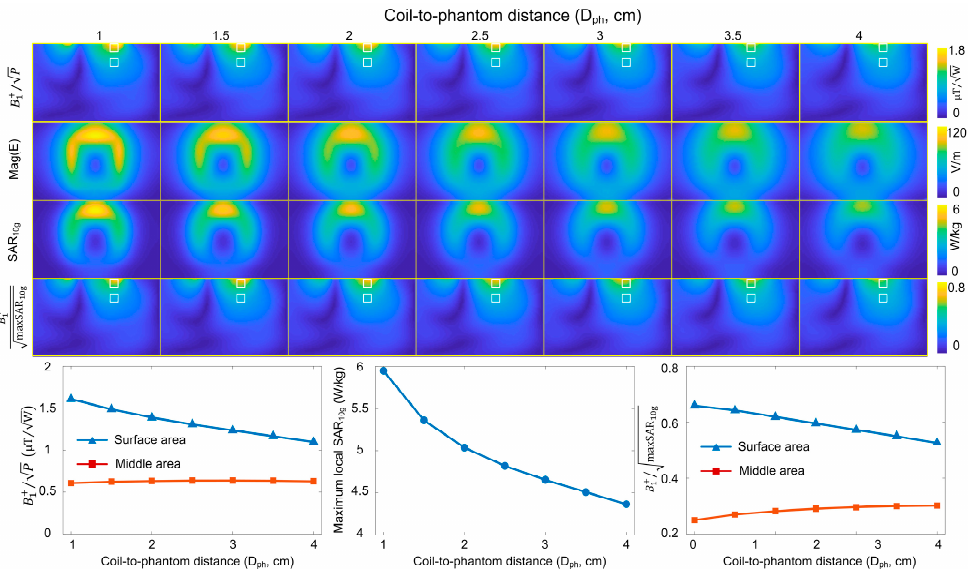
Figure 9. Simulated B 1+ efficiencies, E-fields, local SARs, and B 1+ SAR efficiencies of self-decoupled coils when elevating the whole coil, i.e., all conductors, instead of only the mode and feed conduc- tors. An obvious B 1 decrease was observed and therefore this design is not recommended.